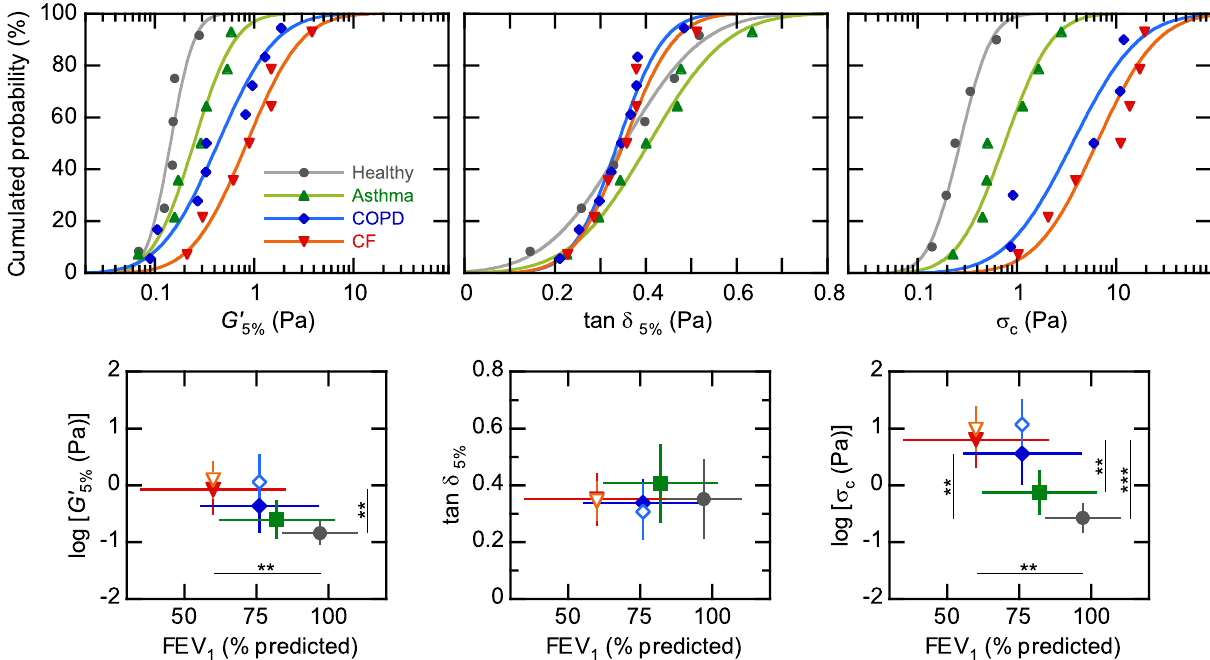
Figure 4. Rheological levels in several bronchial conditions. Top: probability plots of the values of G ′ 5% , tan δ 5% and σ c measured from subjects with the four conditions (healthy, ; asthma, (cid:31) ; COPD, (cid:31) ; CF, (cid:31) ). Each symbol • corresponds to the per-patient average value after HSS nebulisation; solid line is a fit with Eq. (1). Bottom: (cid:31) ) of these rheological parameters, compared by condition, as a expected values and standard deviations ( X 0 ± function of the corresponding relative FEV 1 (mean ± standard deviation). Filled and open symbols depict HSS- induced and spontaneous sputa, respectively. ** p < 0.01 ; *** p < 0.001